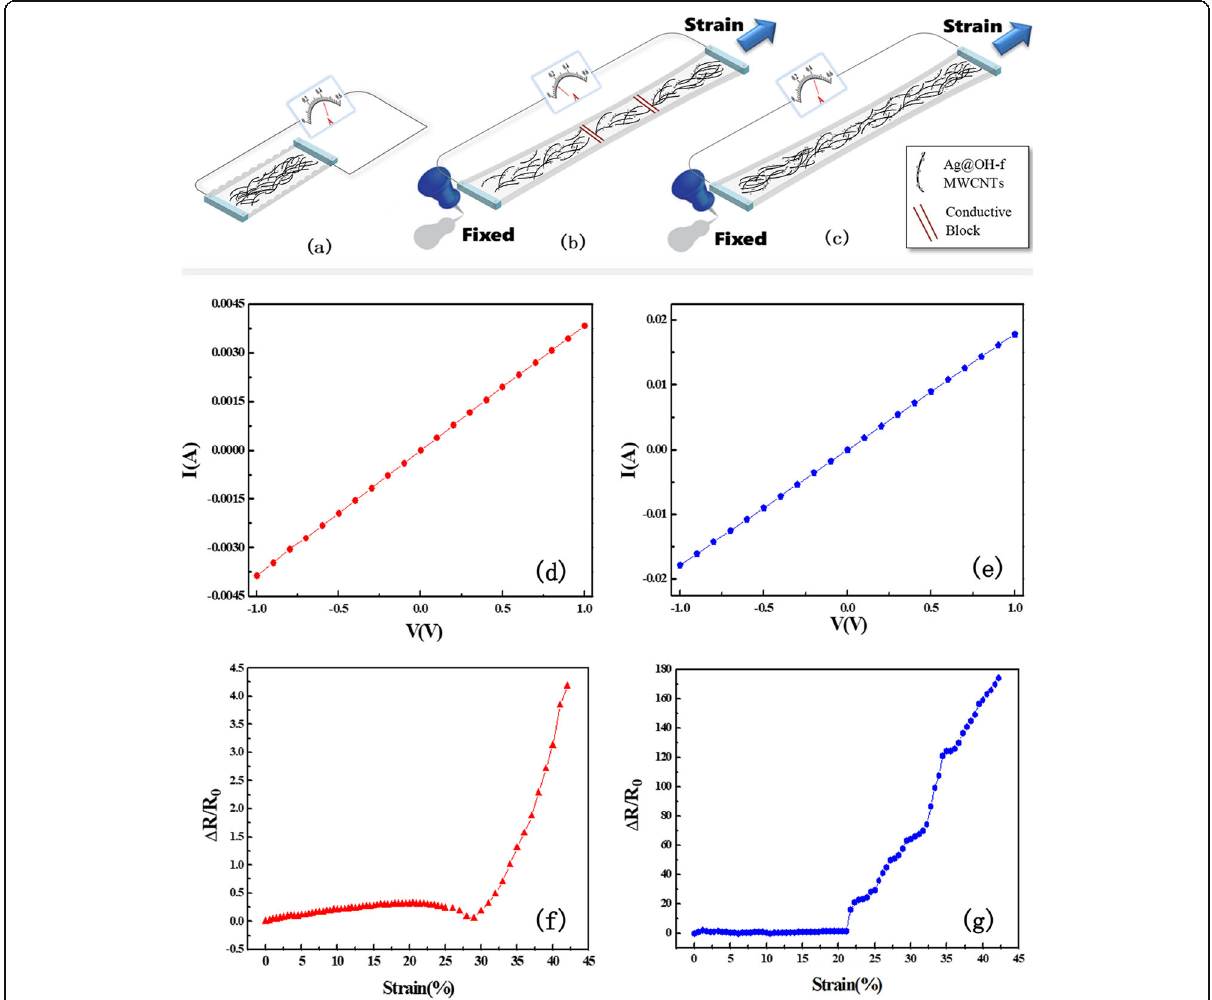
Fig. 4 Stretch test of the soft strain sensor. a , ( b ), and ( c ) Schematic sensing model; I-V curves of ( d ) Ag@OH-f MWCNT-based soft strain sensor without wrinkled structure and ( e ) Ag@OH-f MWCNT-based soft strain sensor with wrinkled structure. The relative resistance changes of the sensors with ( f ) Ag@OH-f MWCNT-based soft strain sensor without wrinkled structure and ( g ) Ag@OH-f MWCNT-based soft strain sensor with wrinkled